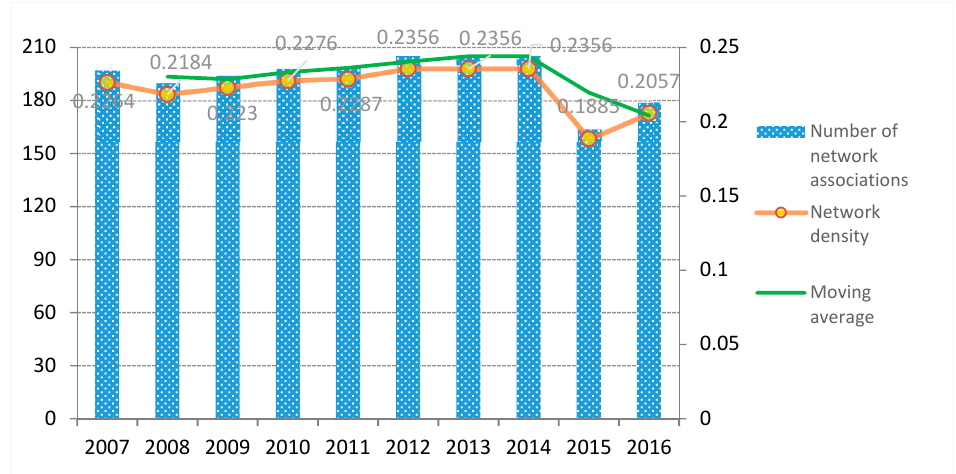
Figure 9. The density and the number of network association in the ANTCE network.